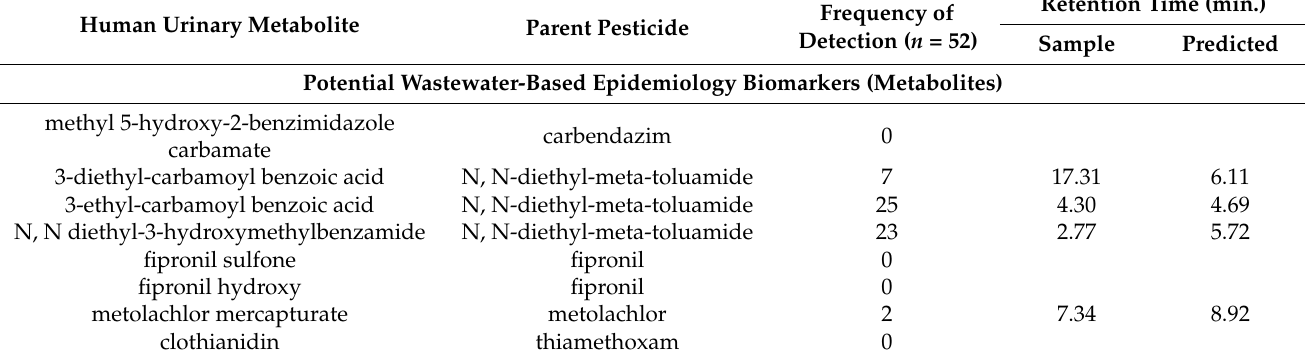
Human Urinary Metabolite